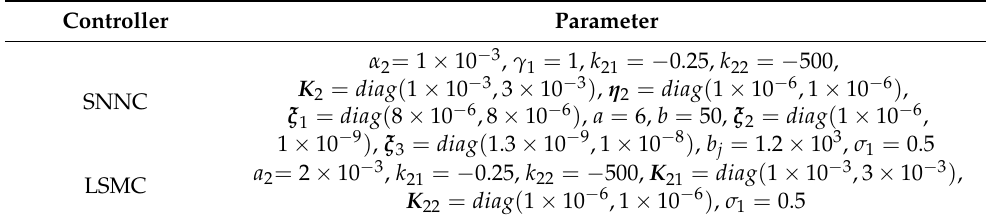
Table 4. Closed-loop controller parameters without in-track control.